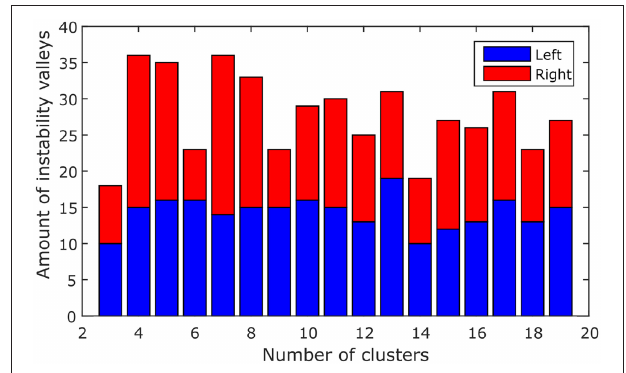
FIGURE 1 | The amount of valleys that are found at each number of clusters among 58 subjects. Blue, left hemisphere; red, right